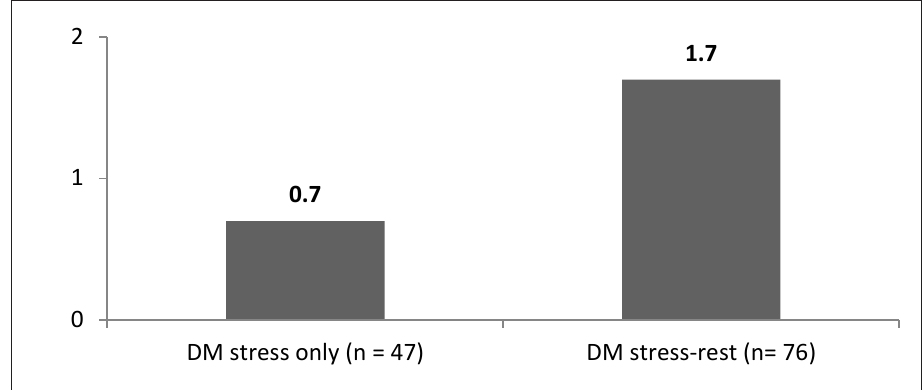
Fig. 3. Hard events per year (%) in diabetic patients (DM) with normal study. Significant higher incidence of hard events was observed in patients who underwent full stress-rest imaging ( P <